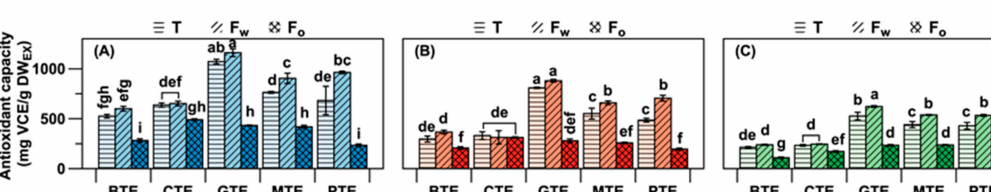
Figure 4. Antioxidant capacities of five tea extracts and their fractions. ( A ) ABTS, ( B ) DPPH, and ( C ) FRAP. Legends: labels T, Fw, and Fo on the graph indicate whole extract, W FR , and O FR , respectively. Lowercase letters a–g on the bars indicate significant di ff erences according to the Tukey–Kramer honestly significant di ff erence test ( p < 0.05). VCE stands for vitamin C